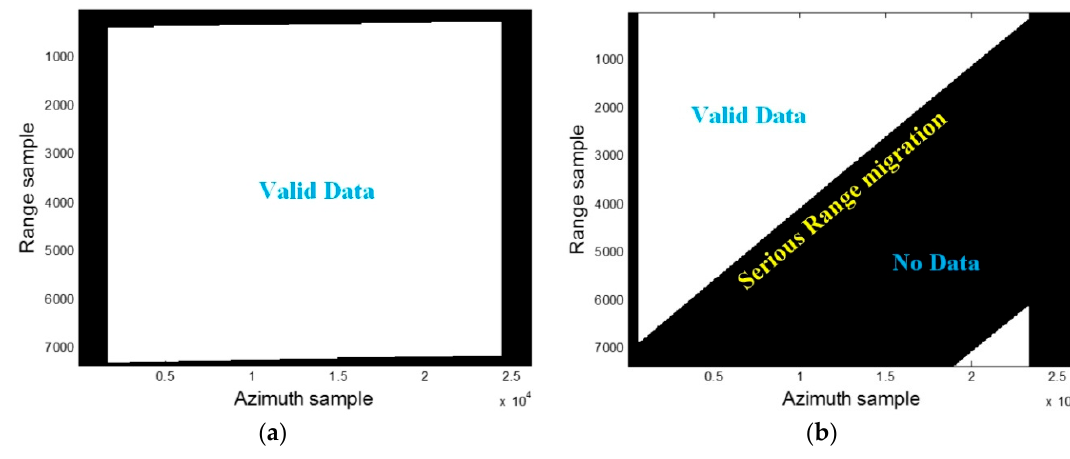
Figure 10. Simulated echoes when: ( a ) using the CVPI technique; and ( b ) not using the CVPI technique. The white and black regions denote the valid data and no data, respectively.